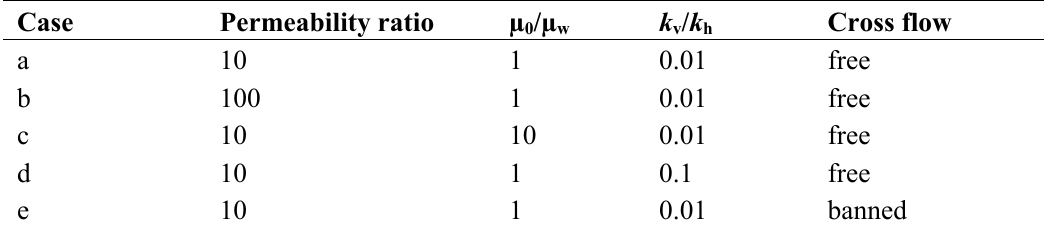
Table 5. The properties of different studied reservoirs for in-depth gel placement. Case